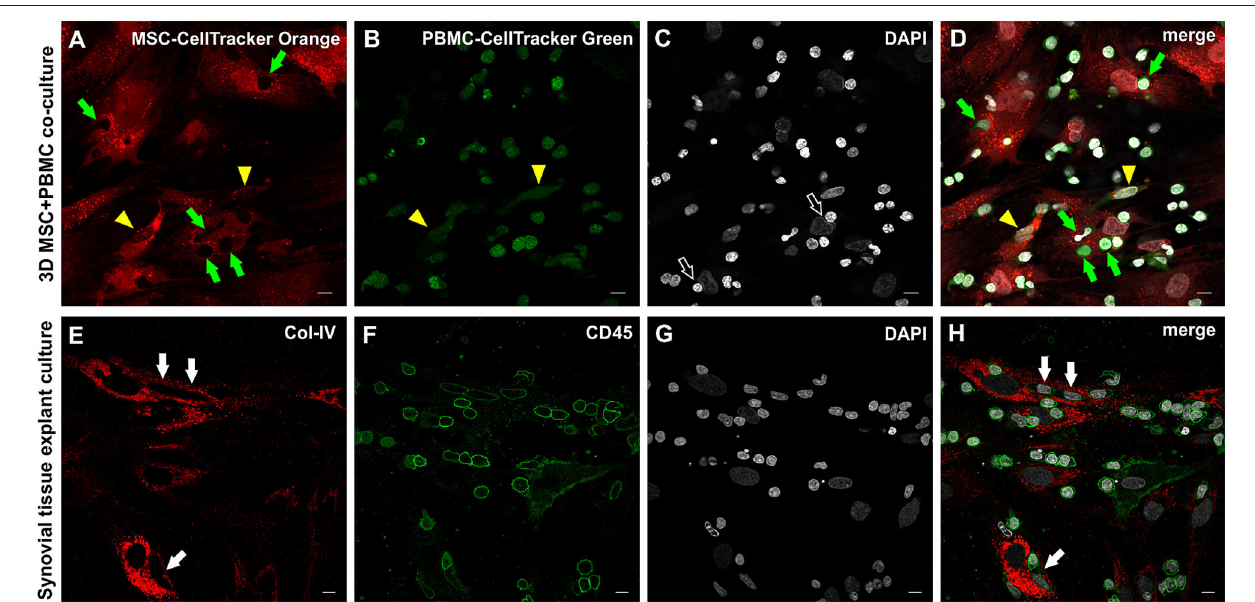
FIGURE 8 | Close physical contact between immune cells and stromal cells in 3D MSC-PBMC co-culture and 3D synovial tissue explant culture. (A) MSC labeled with Cell Tracker Orange fluorescent probe and (B) PBMC labeled with Cell Tracker Green fluorescent probe showing (D) close contact of both cell types with each other (merged image), where leukocytes are in close contact with the cytoplasm of the MSC (green arrows). Note the corresponding empty spaces in the cytoplasm of MSC in (A) . Partial co-staining of both dyes is evident in two cells demonstrating an EC-like nucleus (yellow arrowheads in A , B , D ). (C) DAPI stain showing that some nuclei of stromal cells are indented by round nuclei of PBMC (open arrows). (A–D) Representative CLSM images of bone marrow-MSC cultured with PBMC in 3D fibrin gels on day 4. Scale bars, 10 µ m. Cellular outgrowth from synovial explant tissue cultured in 3D fibrin gels showing (E) Col-IV + stromal cells closely associated with (F) CD45 + leukocytes. (H) Merged image demonstrating the close physical interaction between both cell types. Note that cells with lower CD45 expression in close contact with stromal cells have an elongated EC-like nucleus (white arrows). (G) DAPI stain. (E–H) CLSM images of intact fibrin gel culture of OA synovial tissue on day 20. Scale bars, 10 µ